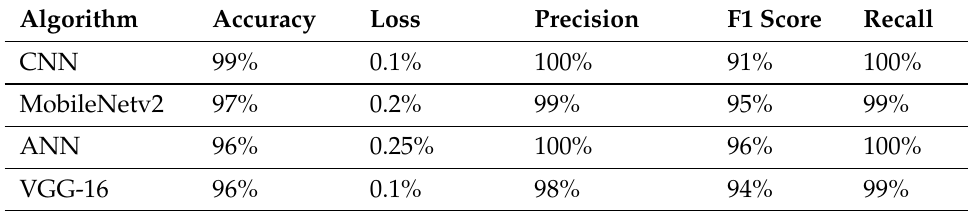
Figure 15. Testing of model on soft rot disease detection. Table 10. Softrot disease